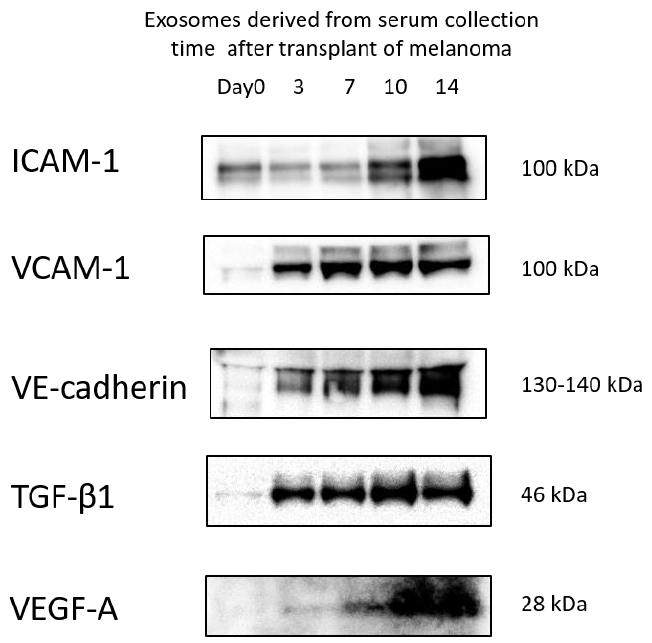
Figure 4. Changes in the levels of ICAM-1, VCAM-1, VE-cadherin, TGF- β 1, and VEGF-A in exosomes isolated from serum at the indicated time points by western blotting analysis.